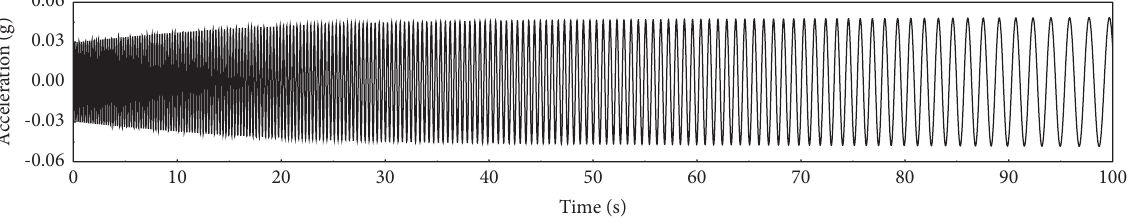
Figure 8: Sweep wave.